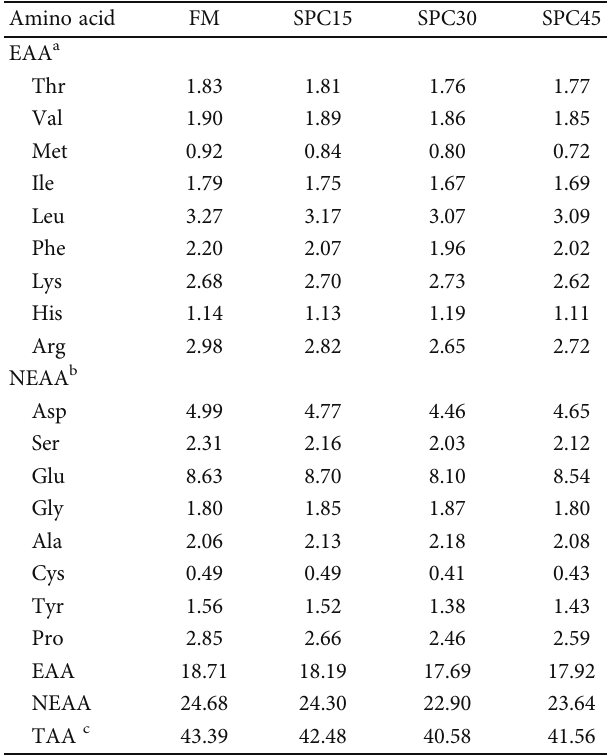
Table 2: The amino acids composition of the experimental diets (dry